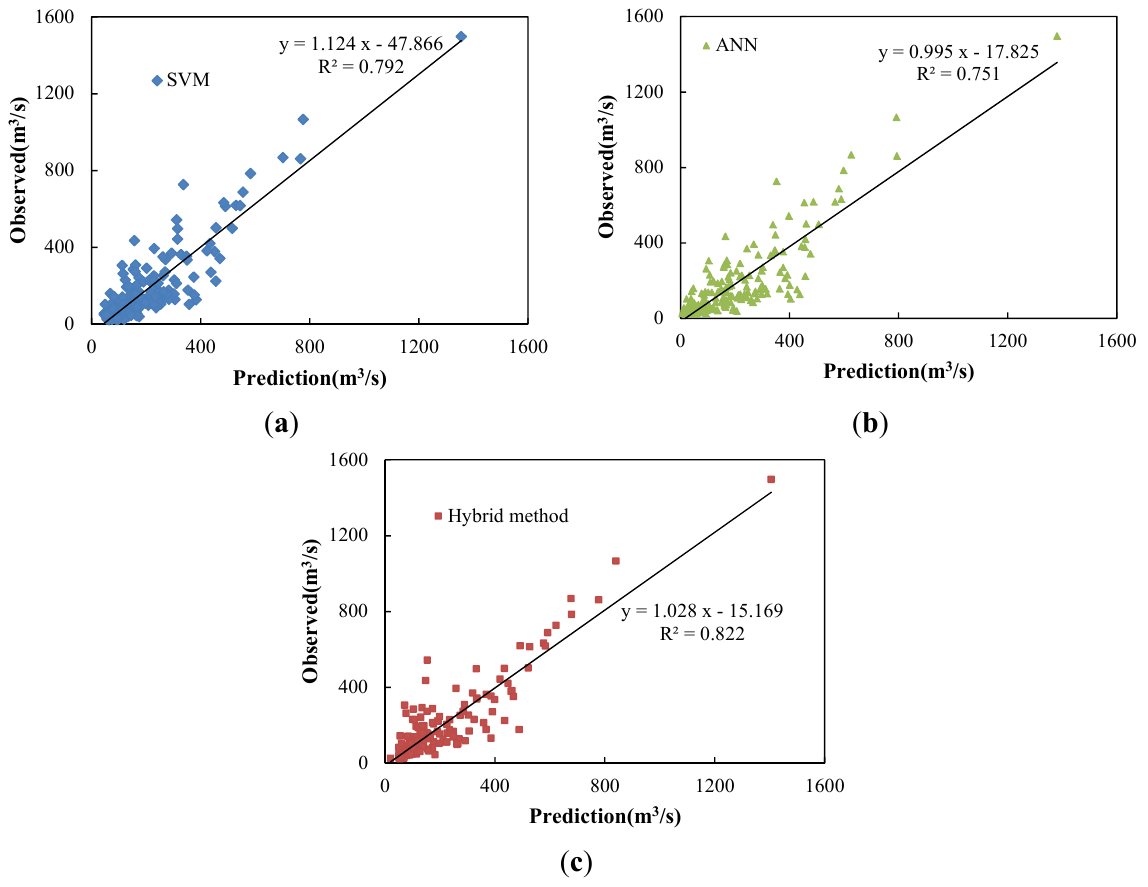
Figure 11. Scatter plots of forecasted versus observed data by various methods during the validation period. ( a ) SVM; ( b ) ANN and ( c ) Hybrid